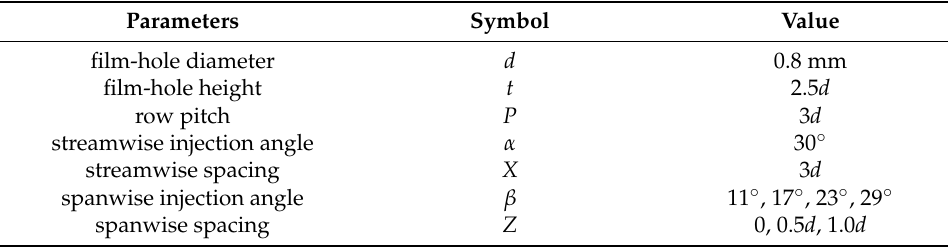
Figure 2. Schematic layout of the DJFC holes. Table 2. Main geometric parameters in the DJFC.